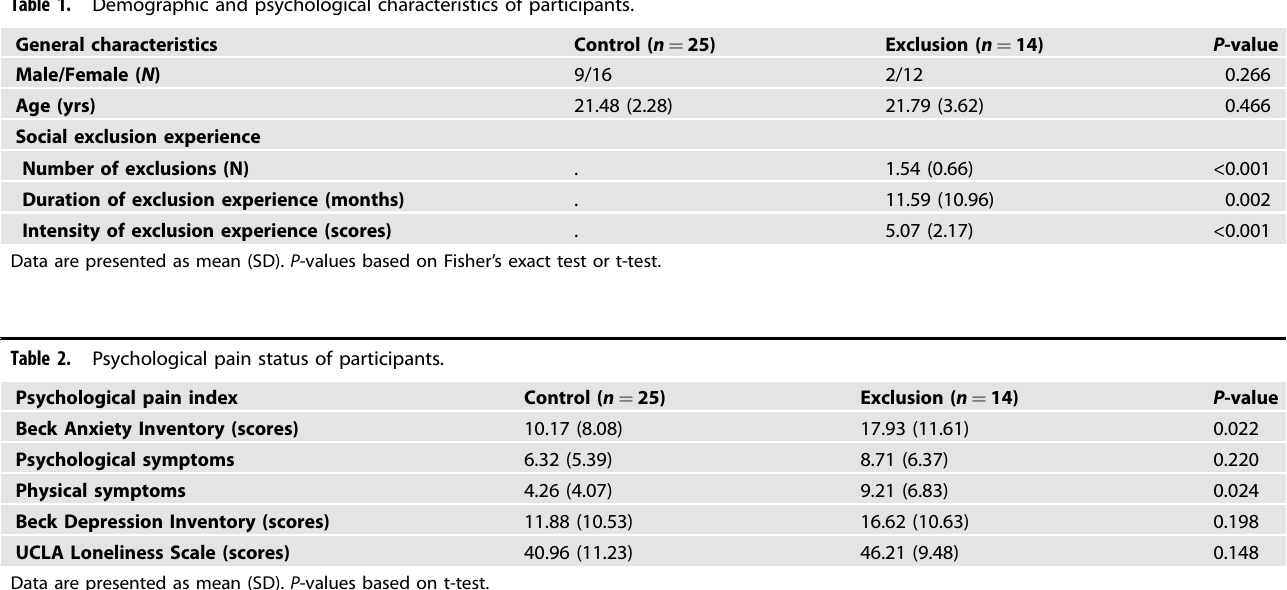
Table 1. Demographic and psychological characteristics of participants.